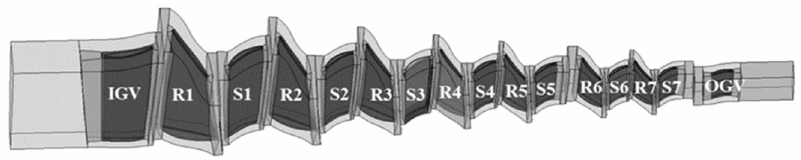
Figure 1. Seven-stage axial transonic compressor.